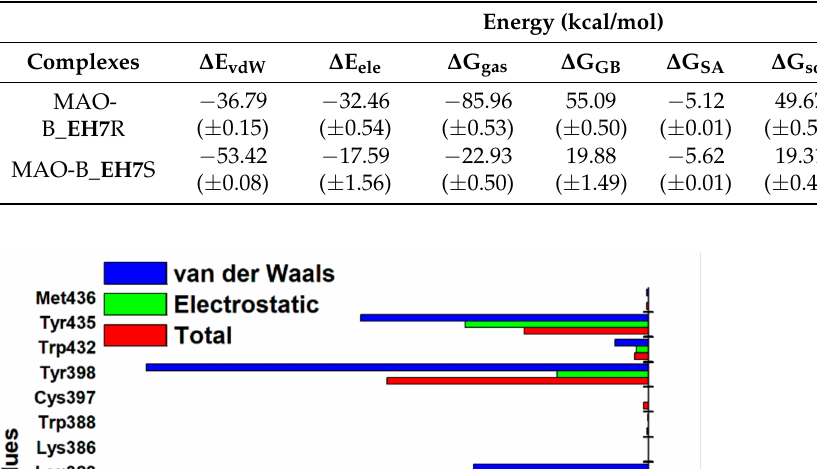
Table 5. The differential free binding energy of MAO-B_ EH7 R and MAO-B_ EH7 S enantiomers.